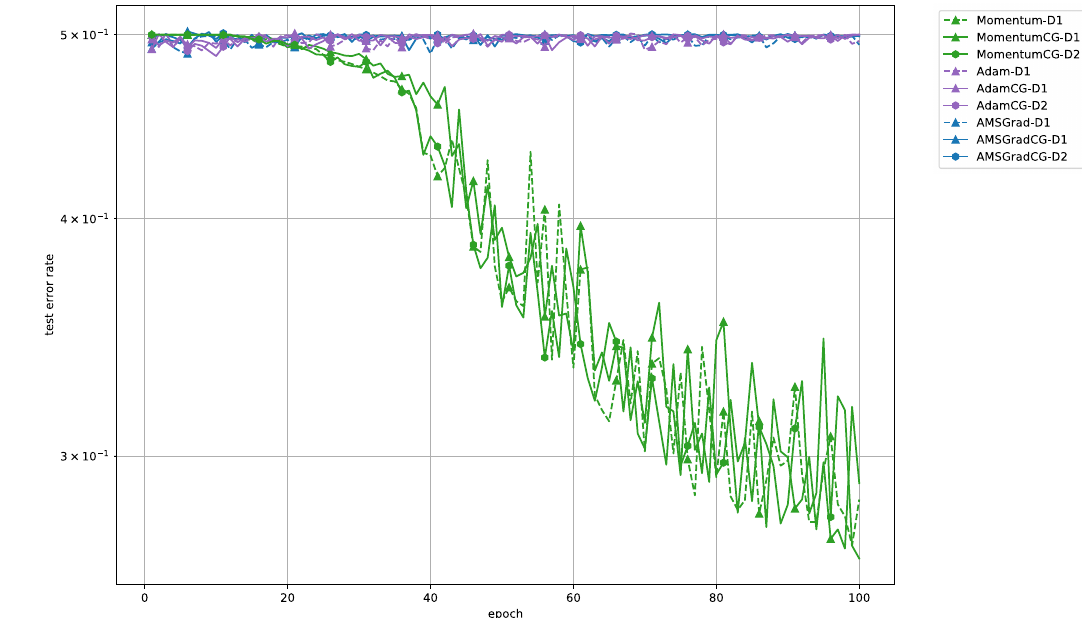
Figure 11. Classification error rate versus number of epochs on the IMDb dataset for training (diminishing).